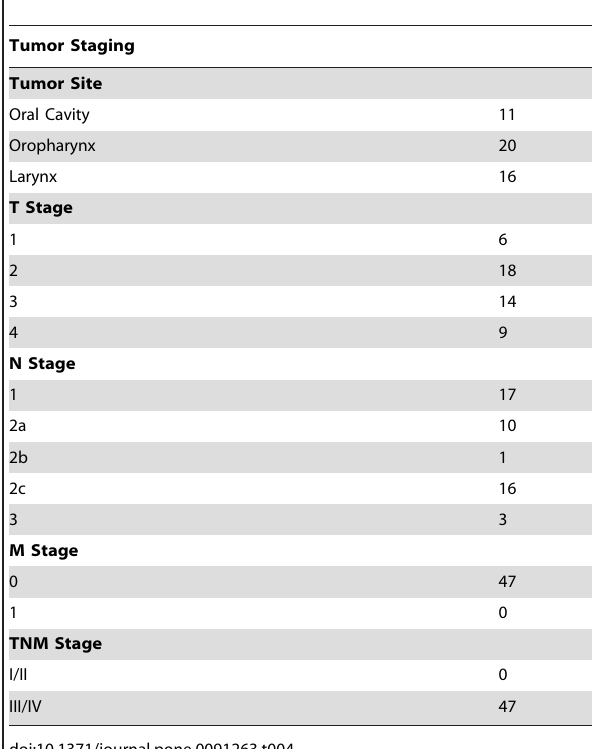
Table 4. Validation tumor clinical characteristics.